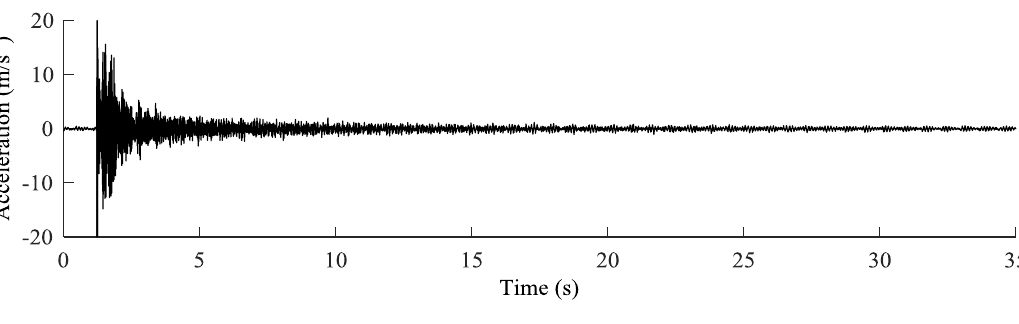
Figure 6. Data recorded by the accelerometers for cable 1TN (see Figure 1a).